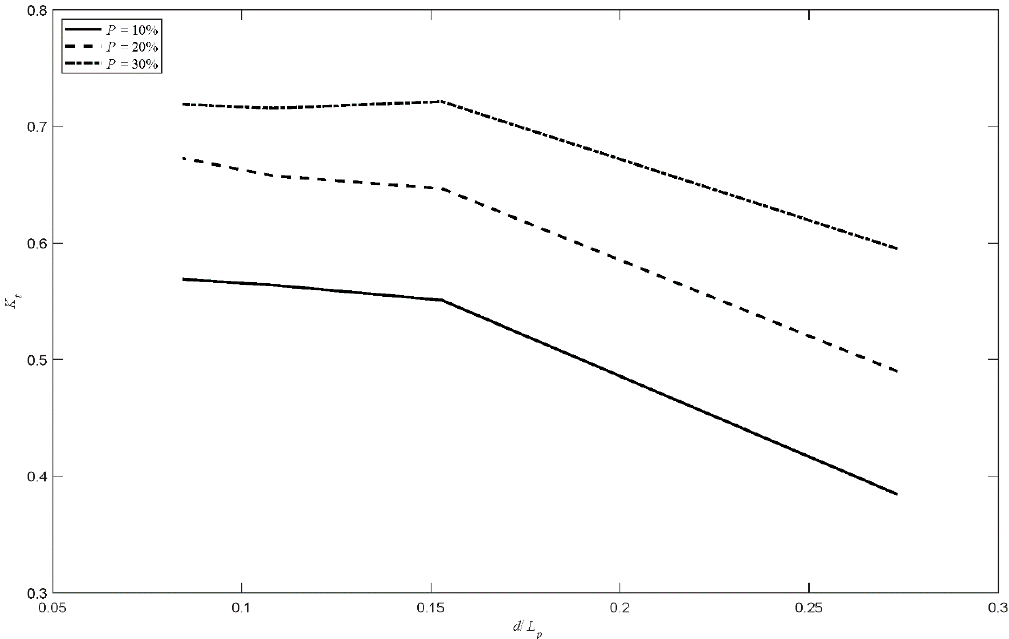
Figure 3. Effect of P on K t for the case of N = 1, θ = 30, and H is / d = 0.2493.